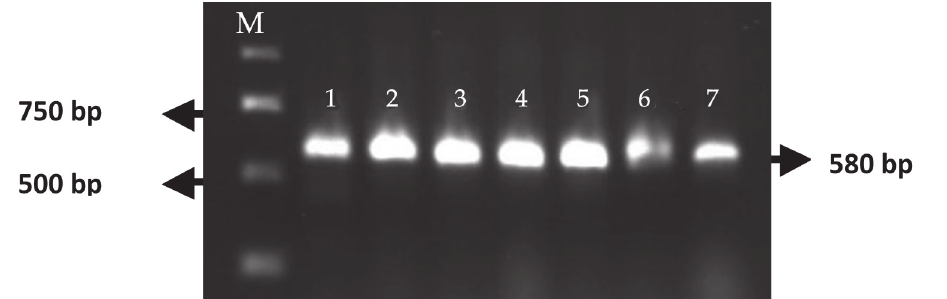
Figure 3. 1% Agarose gel electrophoresis of PCR ampli fi cation of the coat protein, using TY1 (+) and TY2 (-) primers described by Accotto et al ., (2000), from 7 TYLCV isolates in tomato. 1) Ahwaz; 2) Behbahan; 3) Ramhormoz; 4) Dez-